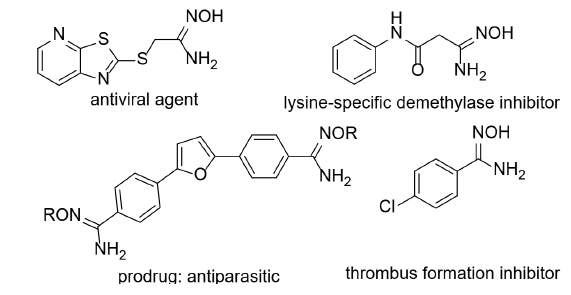
Figure 1. Pharmaceutically relevant